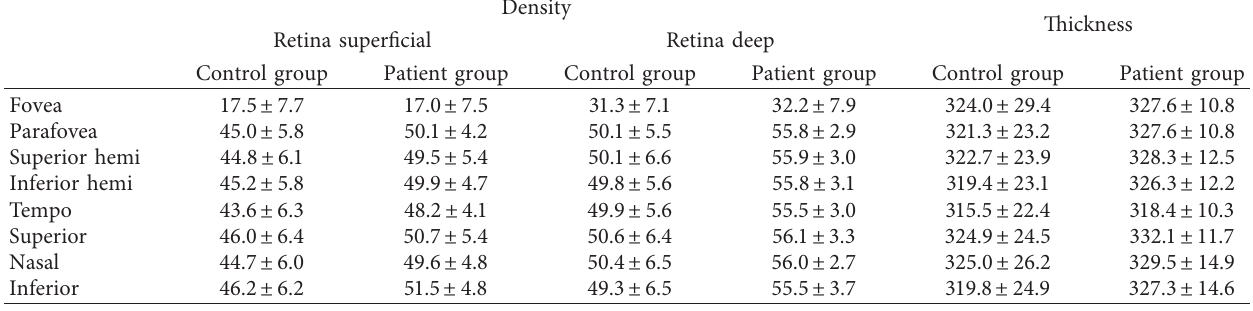
Table 1: Differences vessel density between the control and patient groups obtained with OCTA.